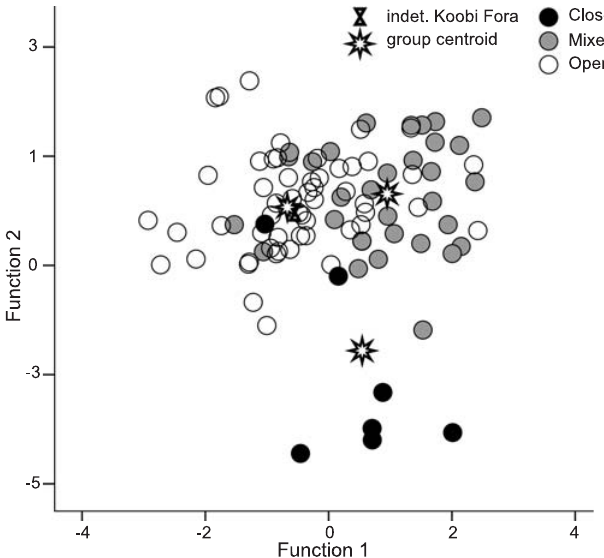
Fig. 3. Plot of the first two linear discriminant functions extracted from a combination of radial measurements used to classify habitat preferences within